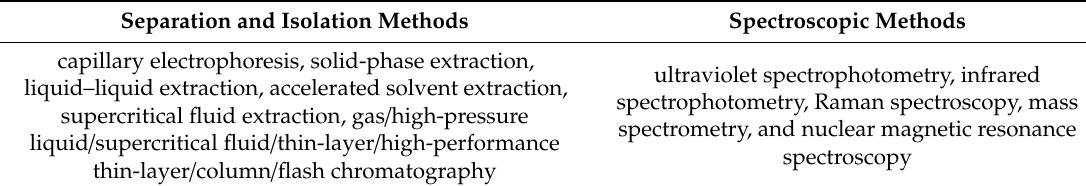
Table 1. Some of the most commonly employed analytical methods in the pharmaceutical